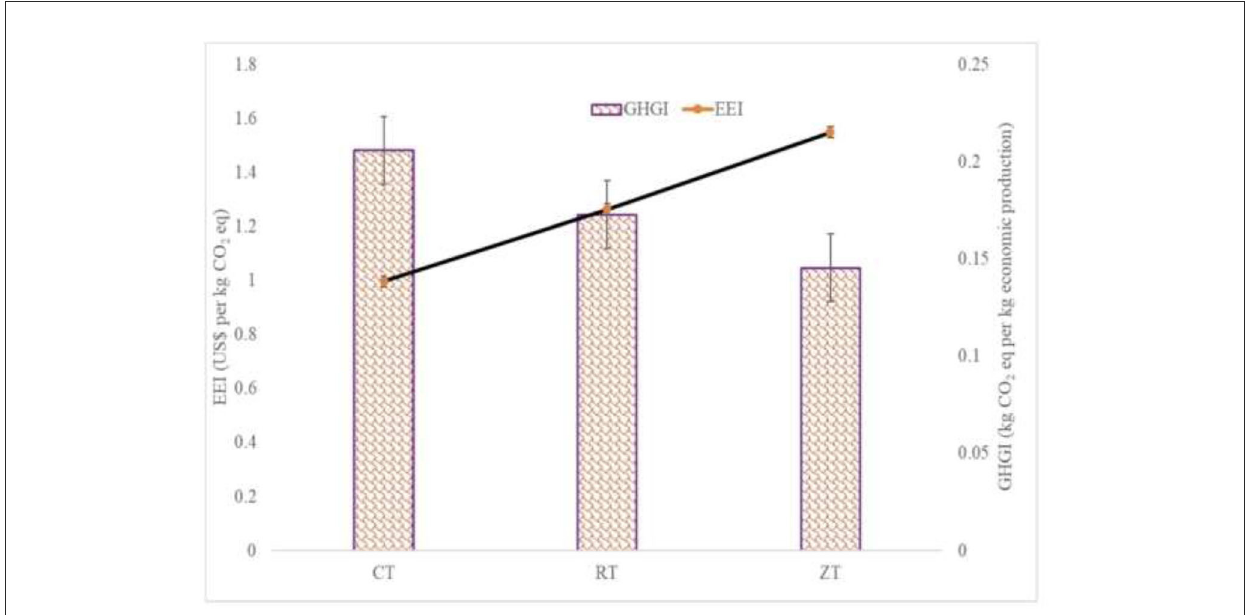
FIGURE4 Effect of tillage practices on eco-efficiency index (EEI) and greenhouse gas intensity (GHGI). CT, conventional tillage; RT, reduced tillage; ZT, zero tillage. Error bar indicates the least significant difference (LSD) values at p =